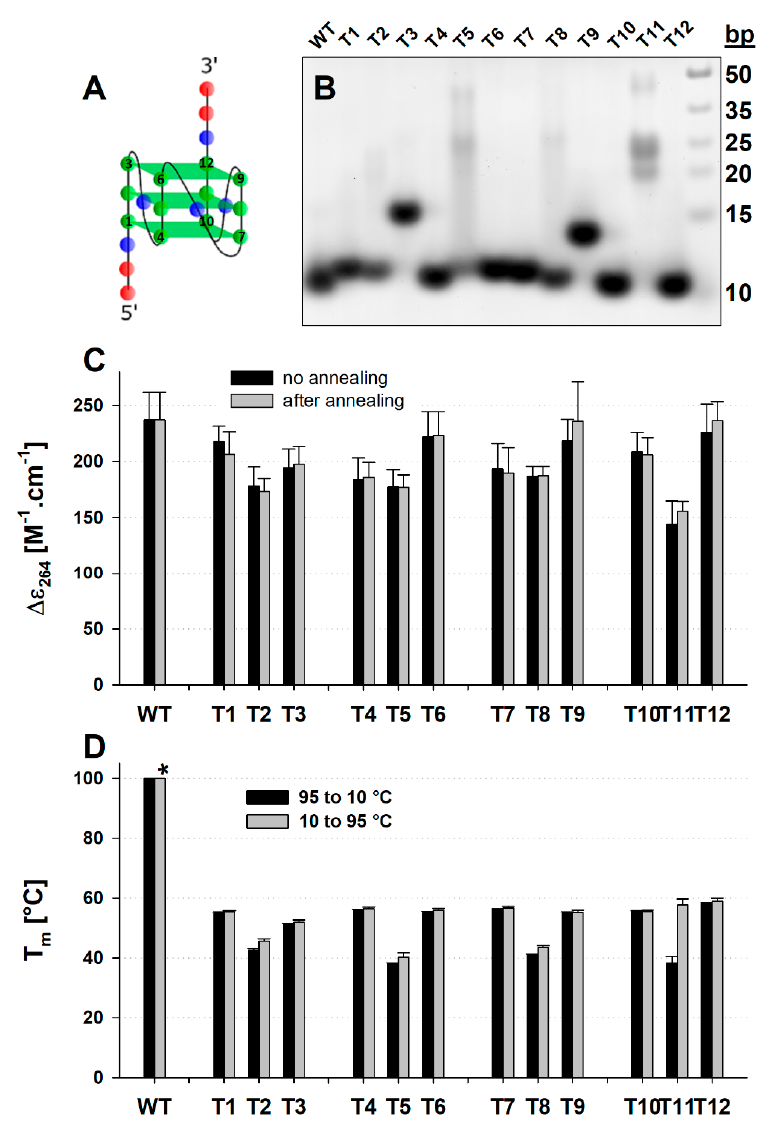
Figure 2. Different parameters of parallel WT sequence and all G/T mutants. ( A ) Schematic structure of the WT G4 with numbering of guanines used for labeling of G to T substituted variants. Green circles represent guanines, red ones adenines and blue circles represent thymines. Green trapezoids represent guanine tetrads. ( B ) Native PAGE. ( C ) The CD264 value (molar DNA strand circular dichroism ( Δε ) measured at 264 nm) before (black) and after (gray) thermal annealing. ( D ) T m values observed from absorbance at 297 nm during renaturation (black) and denaturation (grey) processes. All data were observed in 100K buffer. Native PAGE and CD measurements were done at 23 °C. * T m for WT could not be determined due to extreme thermal stability. Error bars in (C) and (D) represent standard deviations calculated from three independent measurements.